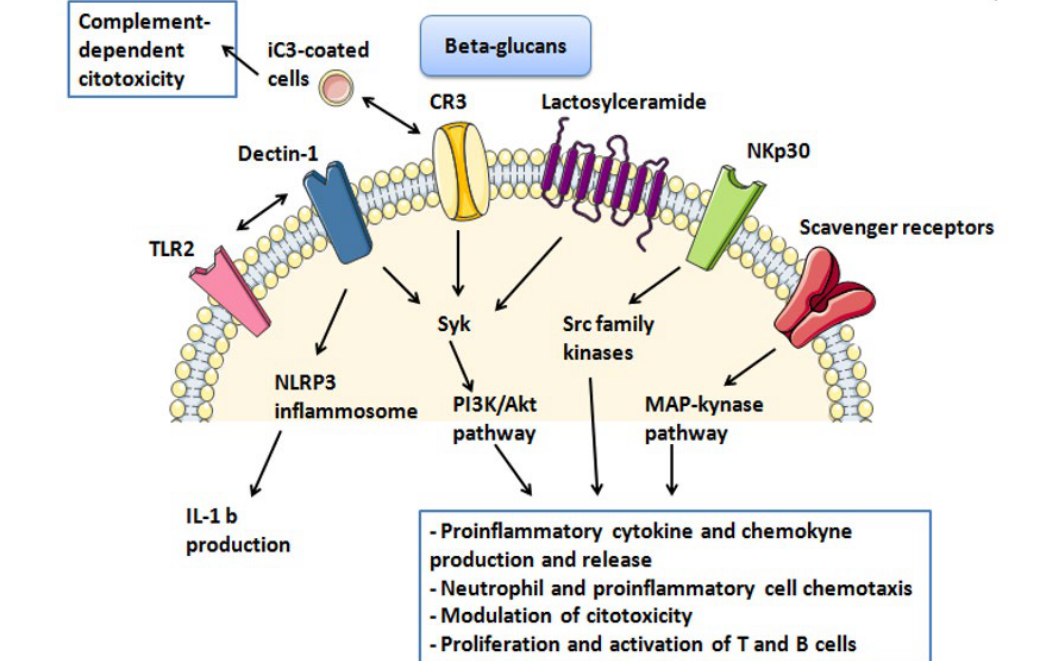
Figure 2. Activation of β-glucan receptors and intracellular pathways. TLR2: toll-like receptor